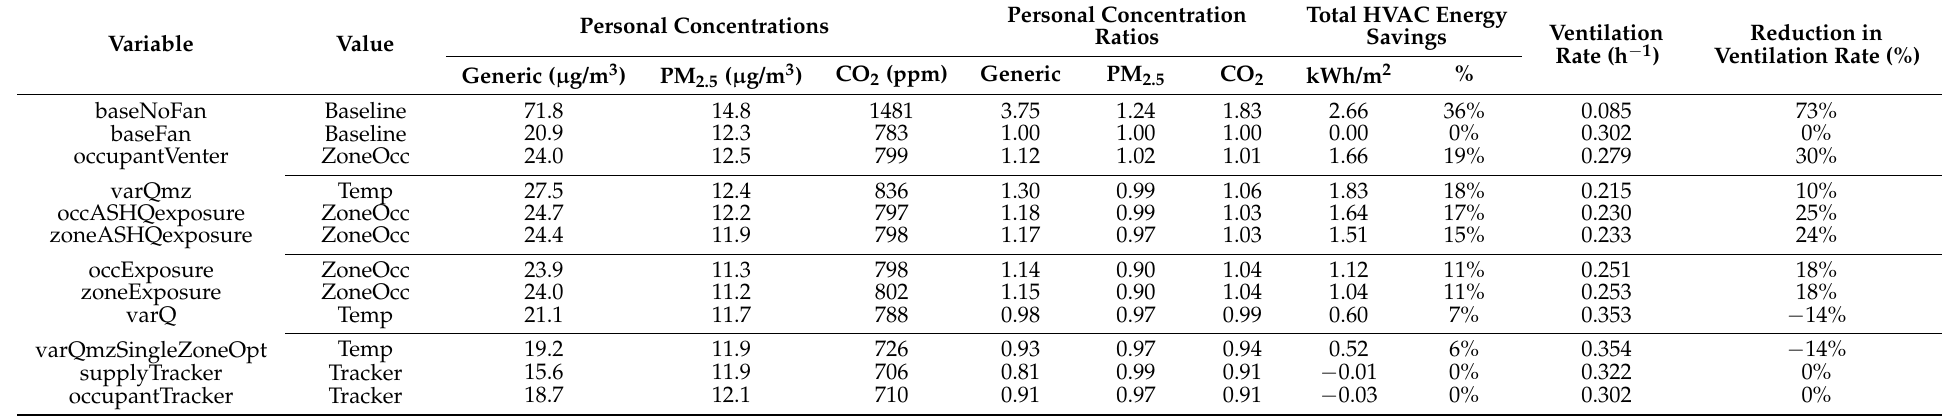
Table 4. Summary of median personal concentrations, personal concentration ratios, energy savings, and ventilation parameters for each ventilation control